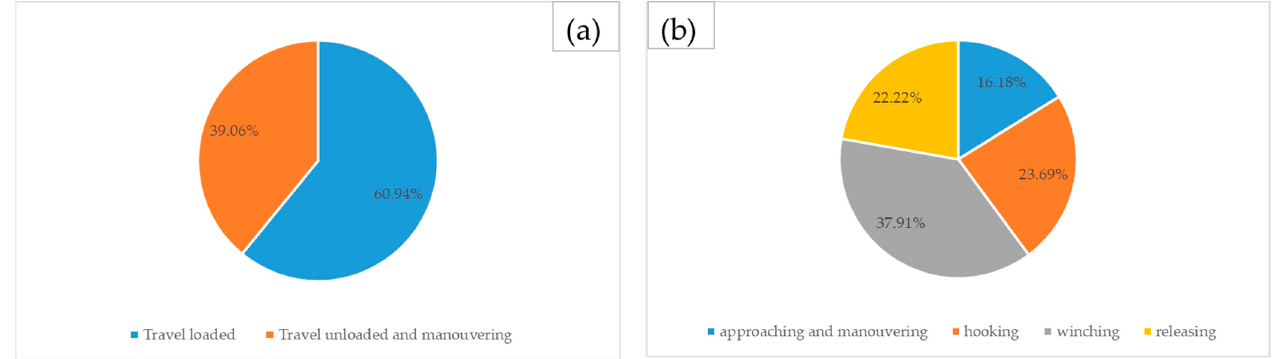
Figure 2. Share of working time without considering delays for CFL ( a ) and WINCH ( b ).